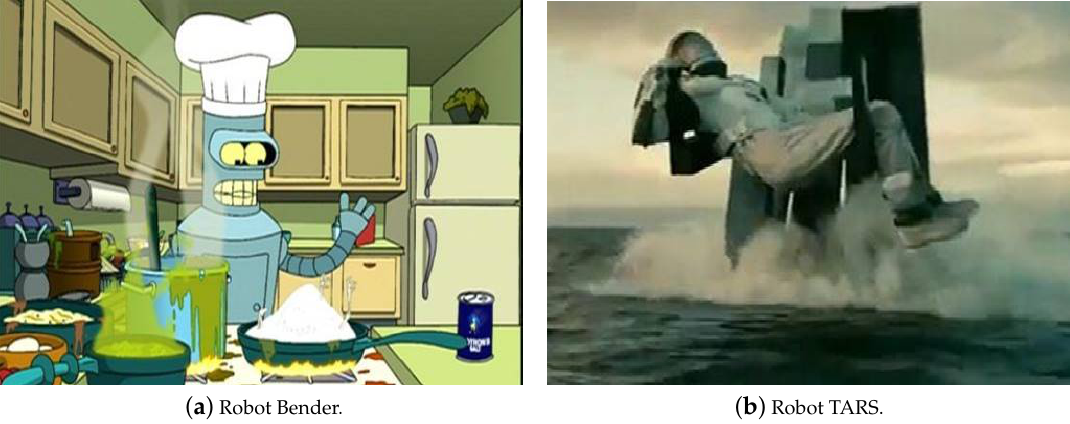
Figure 1. Different examples of TV robots that have appeared in films or series. ( a ) Bender. The foul-mouthed Futurama robot. ( b ) The multi-functional Robot TARS from the Interstellar